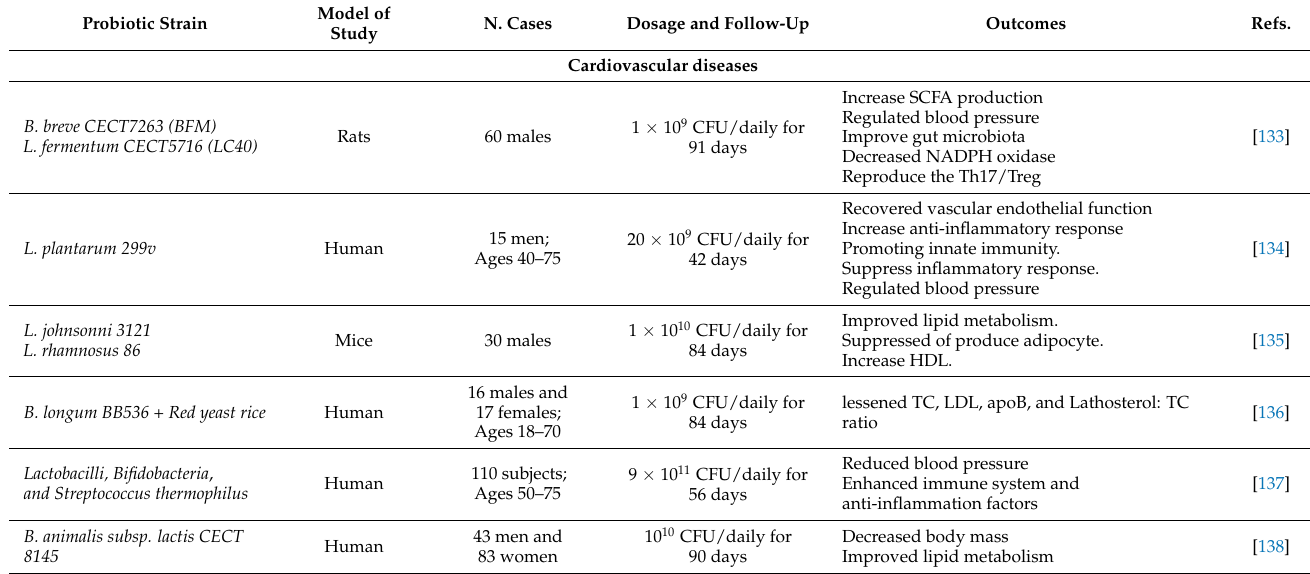
Table A1. Models of human and animal studies regarding the effect of probiotics on human health. Probiotic